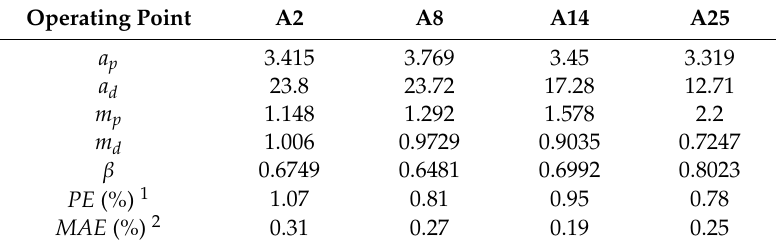
Table 4. Wiebe parameters and predictive